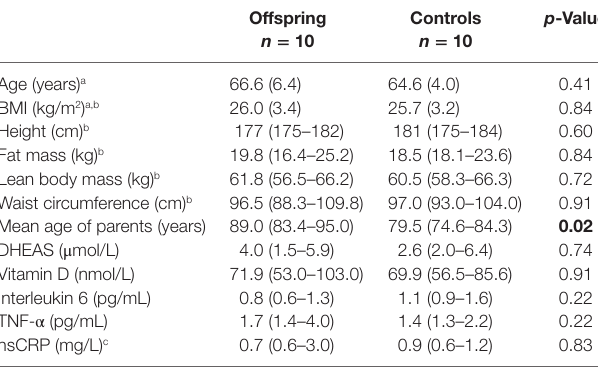
TaBle 1 | group characteristics of male offspring of long-lived families and